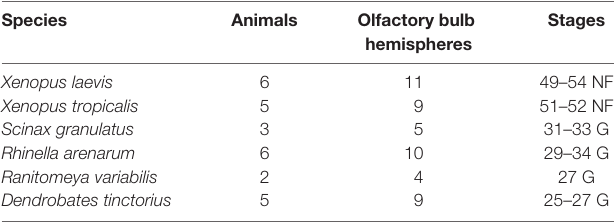
TABLE 1 | Overview of premetamorphotic animals examined in this study. Species Animals Olfactory bulb Stages hemispheres Xenopus laevis 6